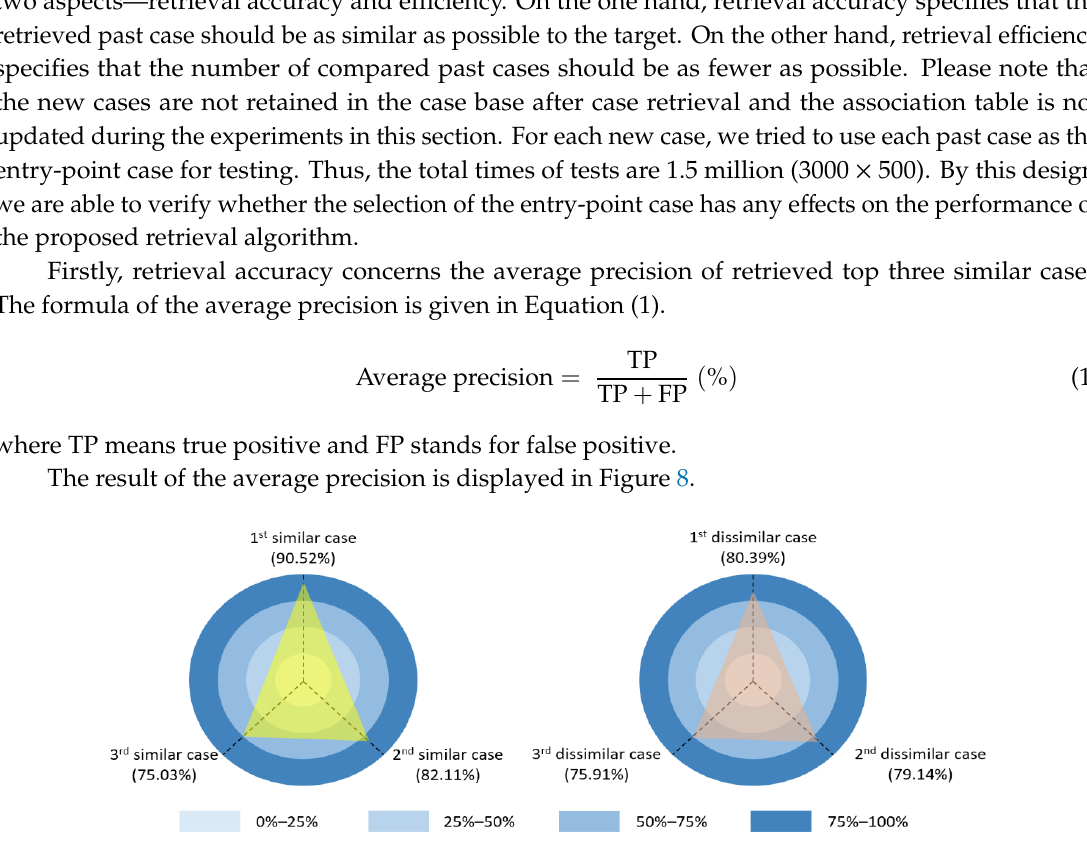
Table 7. Statistical analysis of past cases 984, 748 and 749.